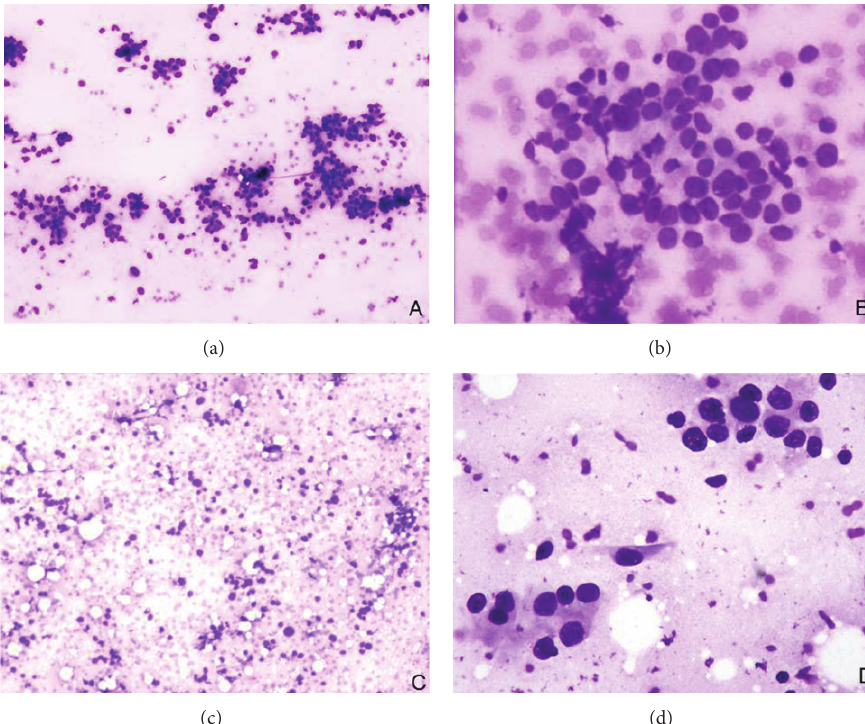
Figure 1: (a) Cases diagnosed as C3 lesion showing slight loss of cohesion of cells (MGG Stain, × 100). (b) Cases diagnosed as C3 lesion showing slight loss of cohesion of cells with mild nuclear atypia (MGG Stain, × 400). (c) Cases diagnosed as C4 lesion showing discohesive cells with moderate nuclear atypia (MGG Stain, × 100). (d) Cases diagnosed as C4 lesion showing loosely cohesive cells with moderate nuclear atypia (MGG Stain, ×